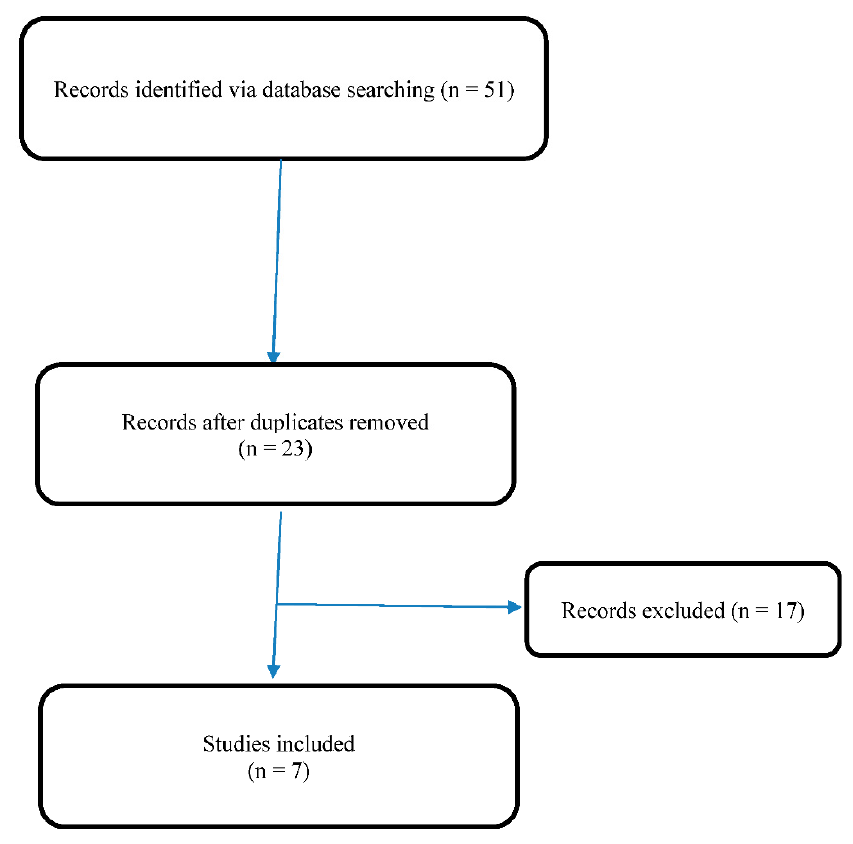
Figure 1. PRISMA flow diagram of the search methodology employed for this review.